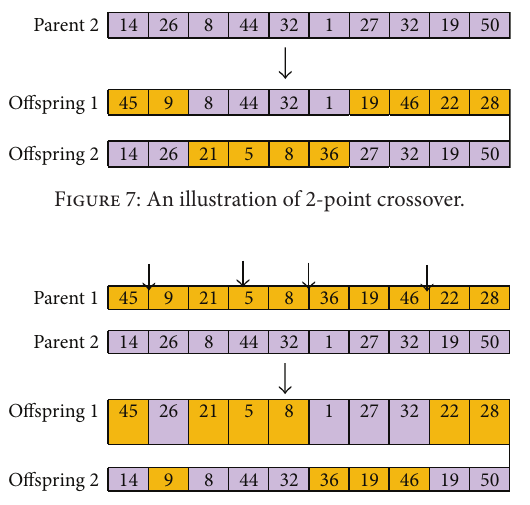
Figure 8: An illustration of 4-point crossover.